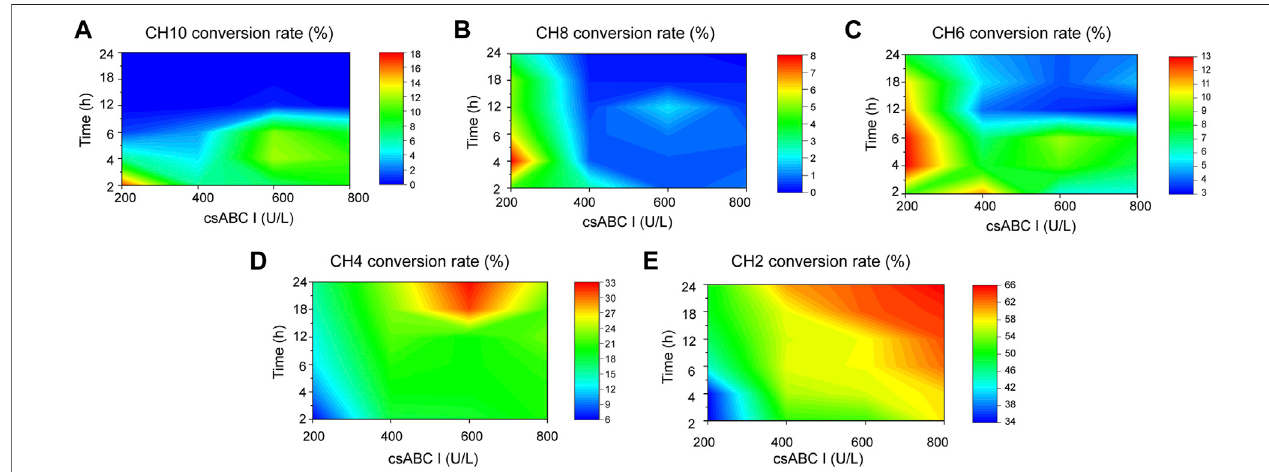
FIGURE 3 | Orthogonalizing csABC I activities and depolymerization time to maximized the yield of o-CHs. (A) CH10, (B) CH8, (C) CH6, (D) CH4, (E) CH2. The csABC I activity and reaction time spanned 200 – 800 U/L and 2 – 24 h, respectively. CH2, disaccharide; CH4, tetrasaccharide; CH6, hexasaccharide; CH8, octasaccharide; CH10, decasaccharide. The data are expressed from three ( n = 3) biologically independent replicates.